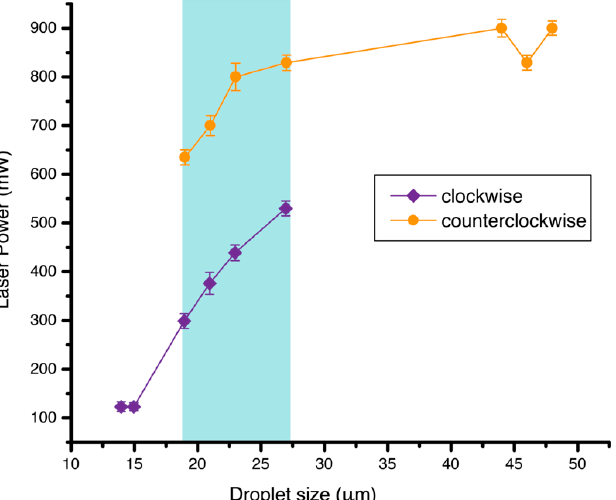
Figure 7. Plot of threshold laser power for droplet rotation in clockwise and counterclockwise directions with droplet size. Notice that there is no counterclockwise rotation of small droplets at high power since the droplets were too small, so they were pushed off the trap at high power. There is no clockwise rotation of larger droplets at low power because the droplets were too heavy for rotation. The force from a low power laser could be too small to initiate droplet motion. Further analysis of angular speed for clockwise and counterclockwise rotation is depicted in Figure 8. It can clearly be concluded from the plot that angular speed of the droplet depends on droplet size and laser power. At low laser power, the droplet rotates clockwise with low angular speed, and at high laser power, the droplet rotates much faster in a counterclockwise direction.